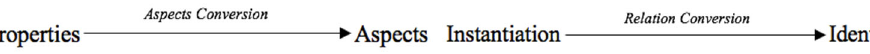
Figure 8. this conversion for heuristic purposes as such: